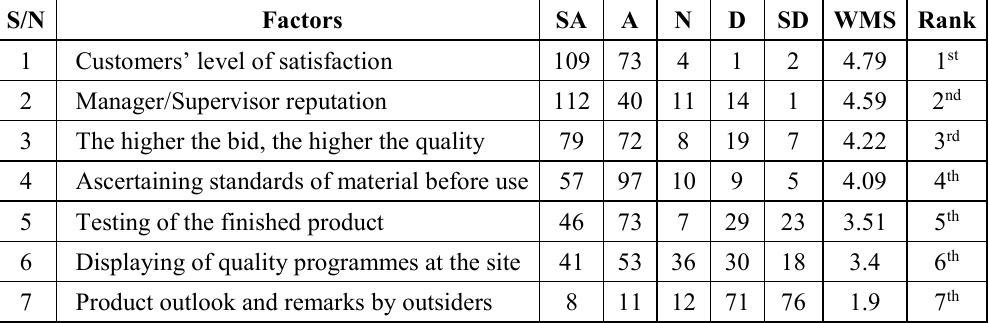
Table 4. Project Managers’ Mode of Assessing Quality of a Finished